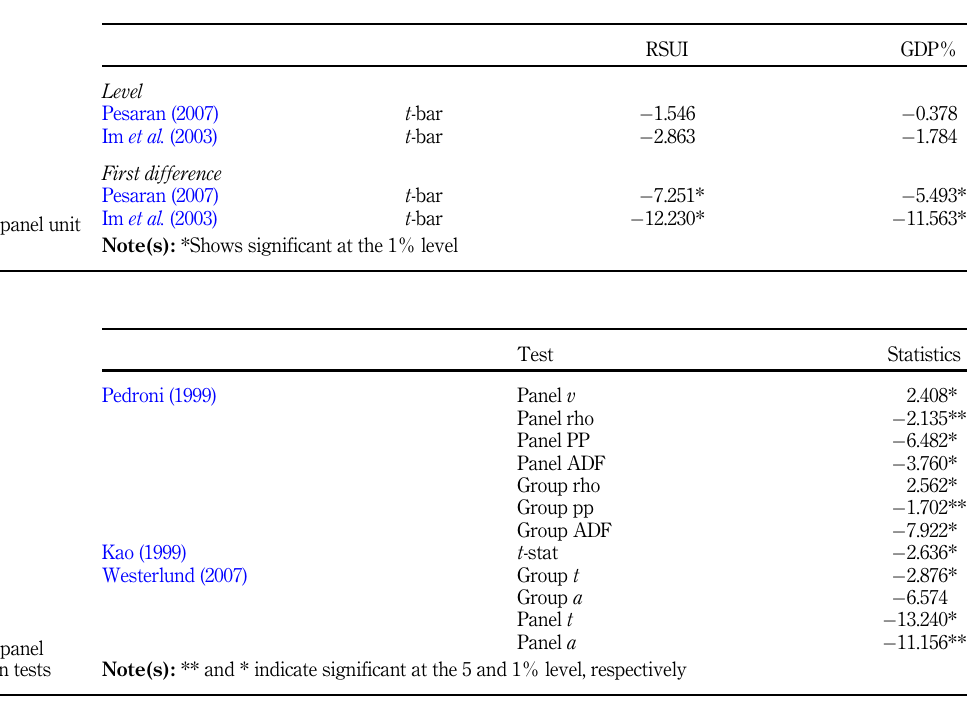
Table 4. Findings of panel cointegration